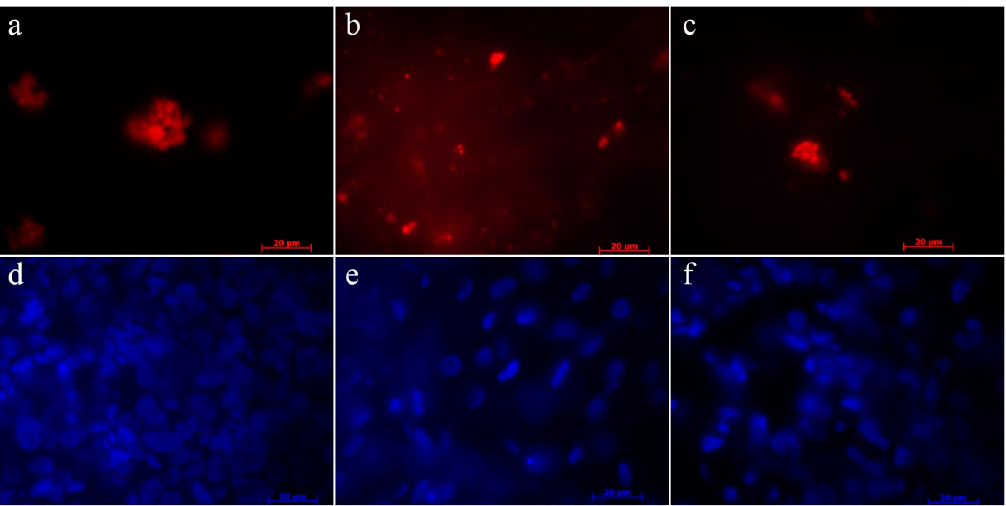
Figure 6. Homing of PKH-26 (red fluorescence) labeled MSC in ( a ) lymph nodes, ( b ) liver, and ( c ) pancreas of the animals of the test group. DAPI-staining of cell nuclei in ( d ) lymph nodes, ( e ) liver, and ( f ) pancreas.